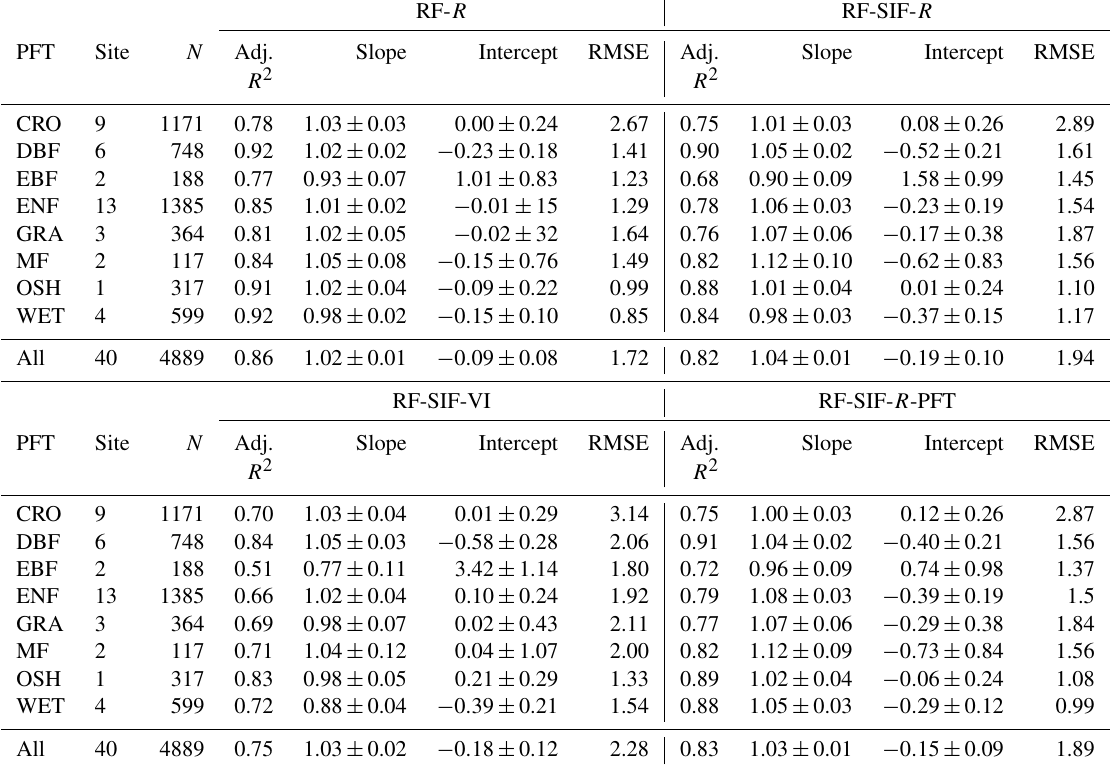
Table 3. Summary statistics of plant-functional-type-specific observed GPP against RF-model-predicted GPP relationships in eight major PFTs: MF, CRO, ENF, DBF, EBF, GRA, OSH, and WET. All pairwise relationships between observed GPP and predicted GPP were statis- tically significant with p < 0 . 0001. The sign ± denotes the 95% confidence interval on the slope and intercept of the relationships between observed GPP and predicted